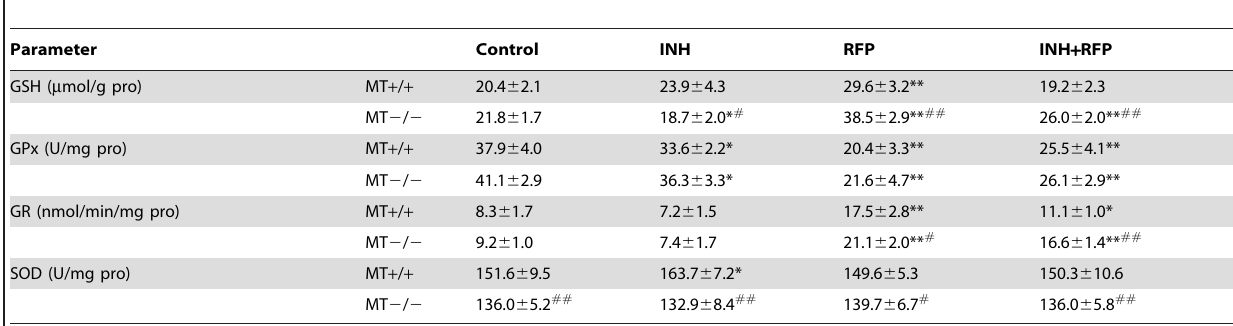
Table 3. Effect of INH and RFP treatment on hepatic oxidative stress of wild-type (MT + / + ) and MT 2 / 2 mice.